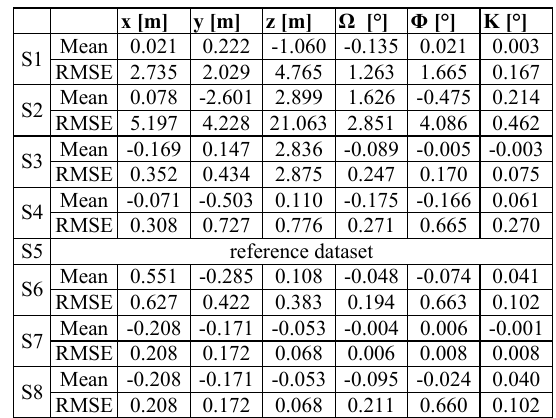
Table 4: Mean and RMSE of EO parameter differences